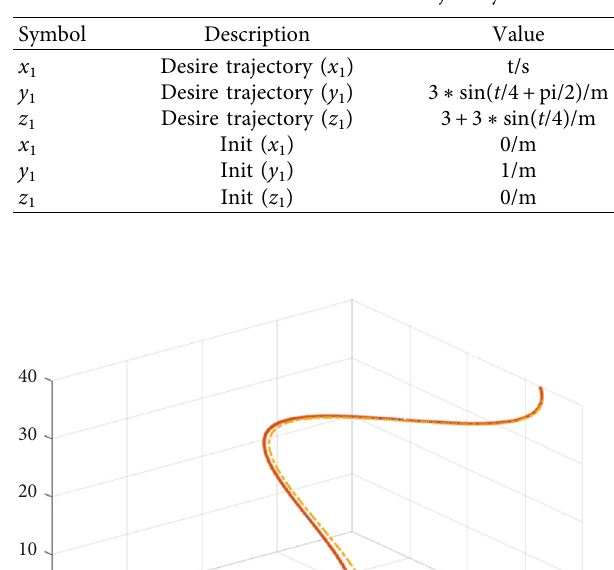
Table 3: Parameters of desired trajectory.